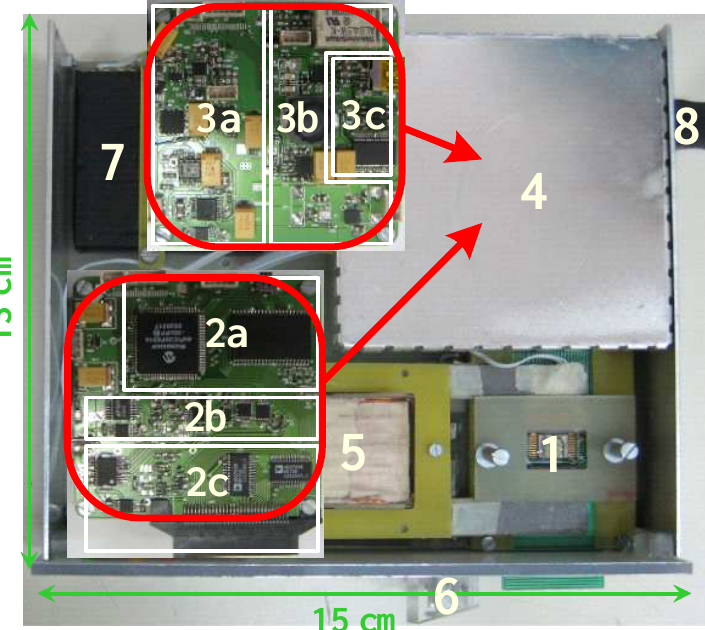
Figure 5. Topview of the platform prototype: 1) biochip encapsulated in a PCB chip